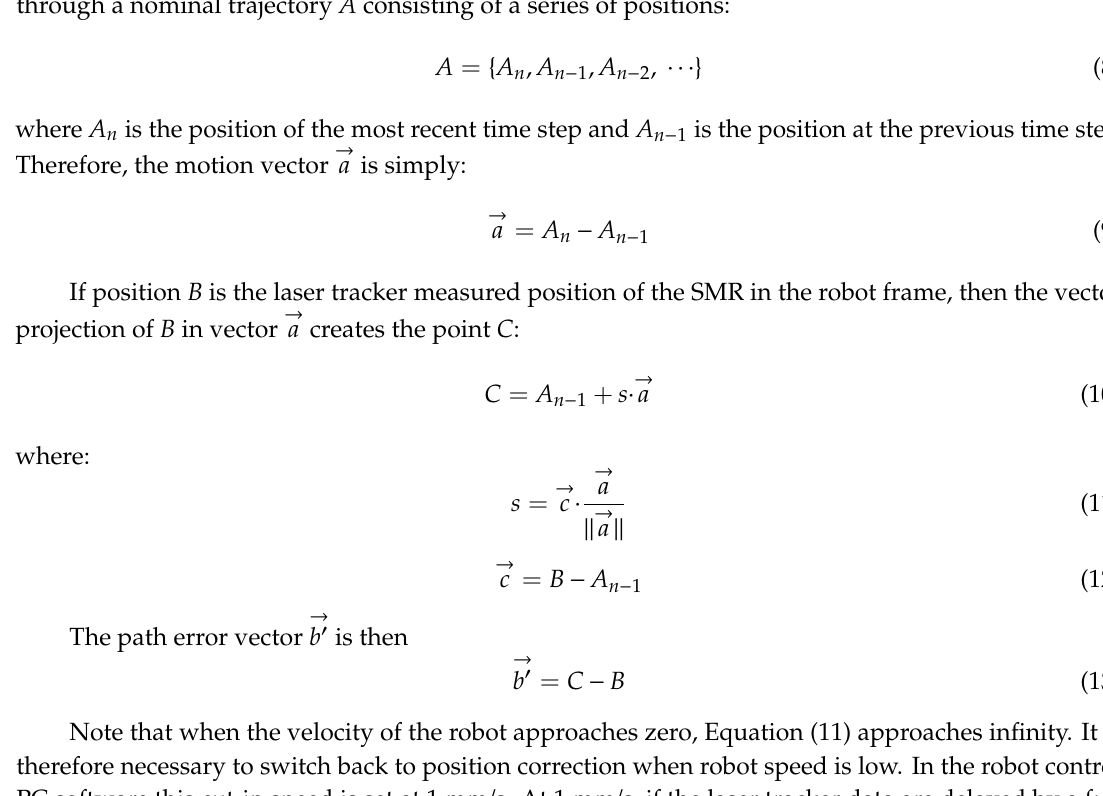
→ b ) vs. path error vector (